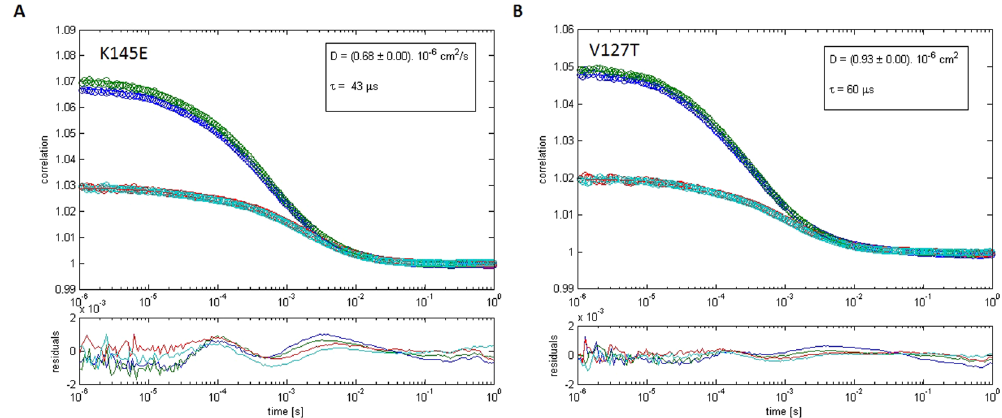
Figure 4. 2fFCS measurements of fluorescent proteins diffusion. FP’s curves were fitted by a triplet model. Dots – data points, lines – fitting curves. Green and cyan curves are first and second focus autocorrelation functions, red and blue curves – cross-correlation curves between two focal volumes. A – K145E SAASoti, B — V127T SAASoti.